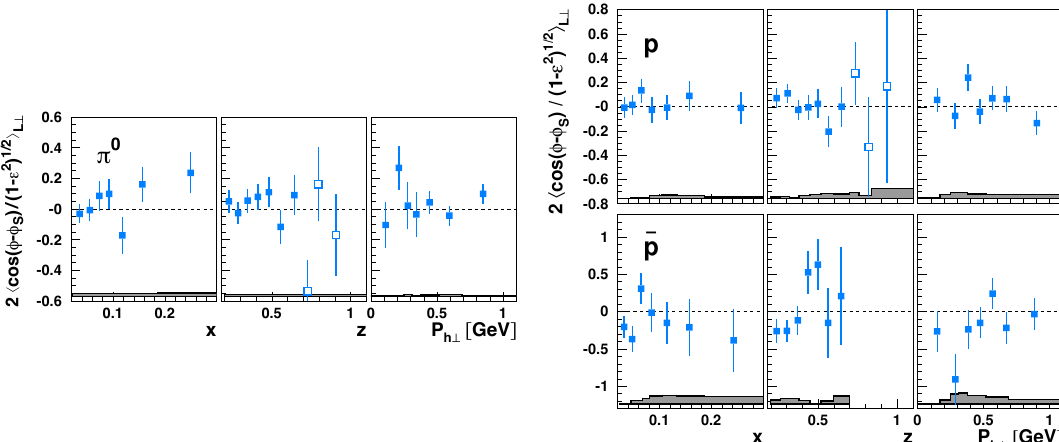
√ Figure 22 . The 2 h cos( φ − φ S ) / 1 − (cid:15) 2 i h amplitudes for π 0 (left), protons, and antiprotons (right) L ⊥ presented either in bins of x , z , or P h ⊥ . Data at large values of z , marked by open points in the z projection, are not included in the other projections (no such high- z points are available for antiprotons due to a lack of precision). Systematic uncertainties are given as bands, not including the additional scale uncertainty of 8.0% due to the precision in the determination of the target and beam